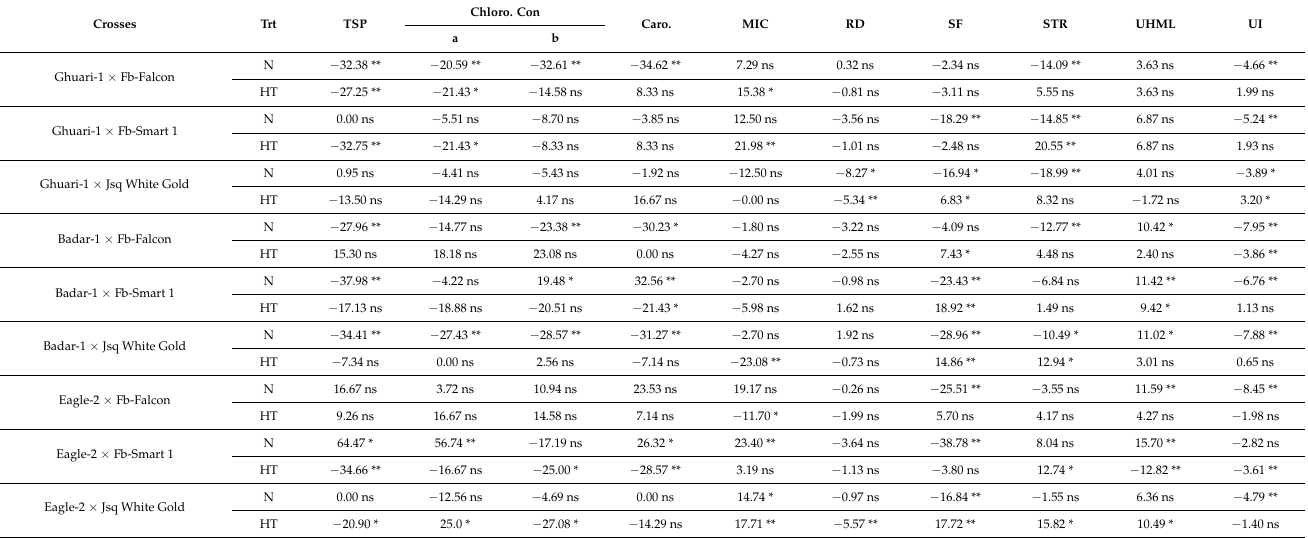
Table 11. First year heterosis effects of various traits under normal and high temperature stress